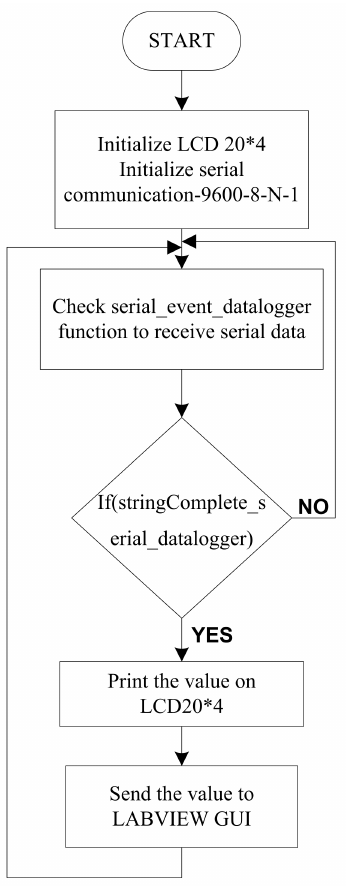
Figure 11. Flow chart for the LabVIEW